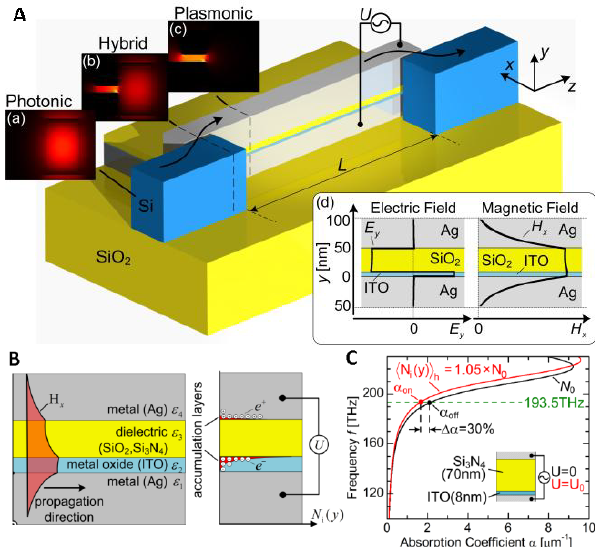
Figure 9: (A) SPPAM: the modulator section consists of a stack of silver, ITO, and silica layers, and can be integrated by means of a directional coupler with a silicon waveguide. The insets show how a photonic mode in the silicon waveguide excites the MIM waveg- uide mode in SPPAM via a hybrid mode in the directional coupler. (B) The absorption coeflcient of the SPP is modulated by applying a voltage between two silver electrodes. (C) The MIM waveguide pos- sesses a plasmonic resonance and is strongly affected by changes in the permittivity of the active layer. Copyright (2011), OSA, from Ref. [128], with permission of the authors. ITO : Indium tin oxide; MIM: Metal-insulator-metal; SPPAM: Surface plasmon polariton absorption